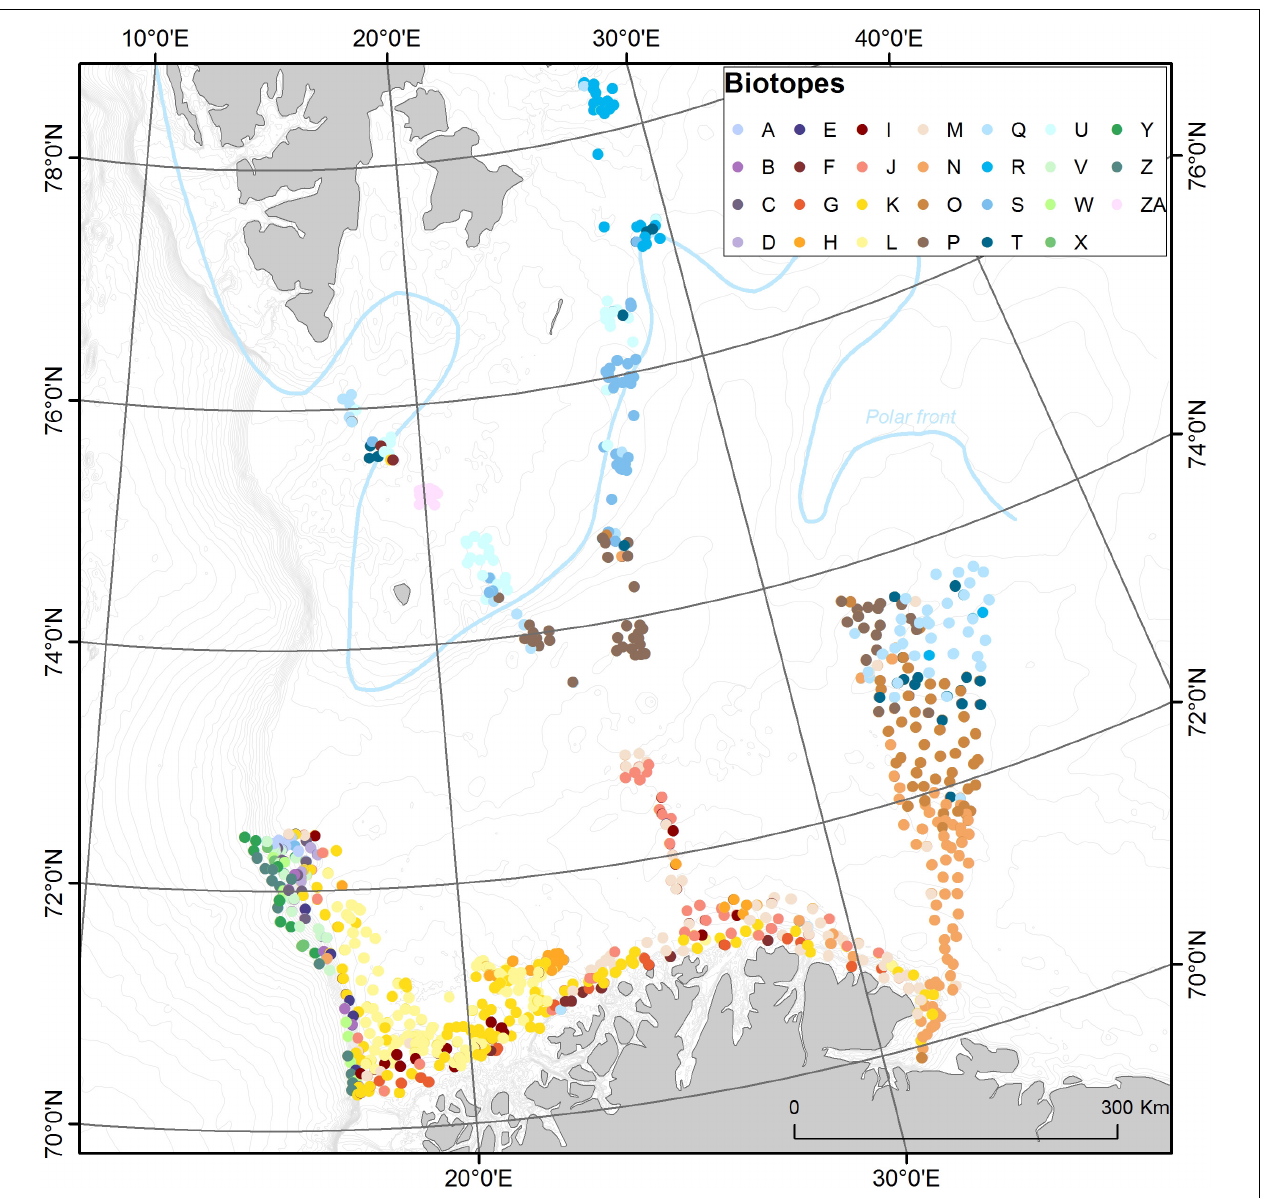
FIGURE 7 | Distribution of video observation locations classified into 27 general biotopes. Colors are roughly grouped according to the water mass splits (greens = NDSW, purples = NSAIW, yellow/browns = NAW, blues = Arctic Water) (cf. Figure 3 ). An approximate location of the polar front is indicated with a blue